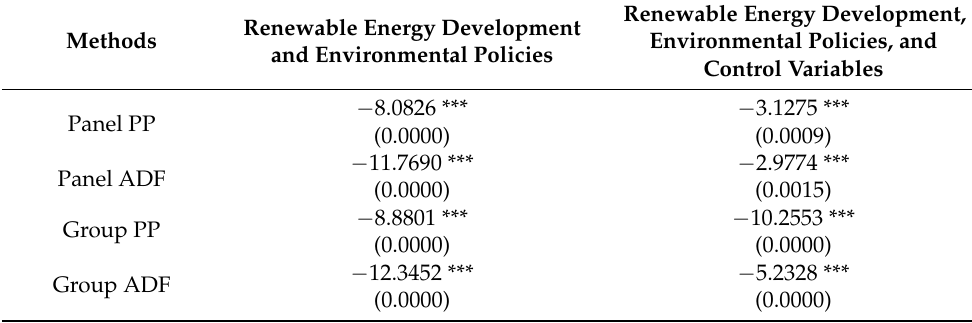
Table 4. A cointegration test of the related